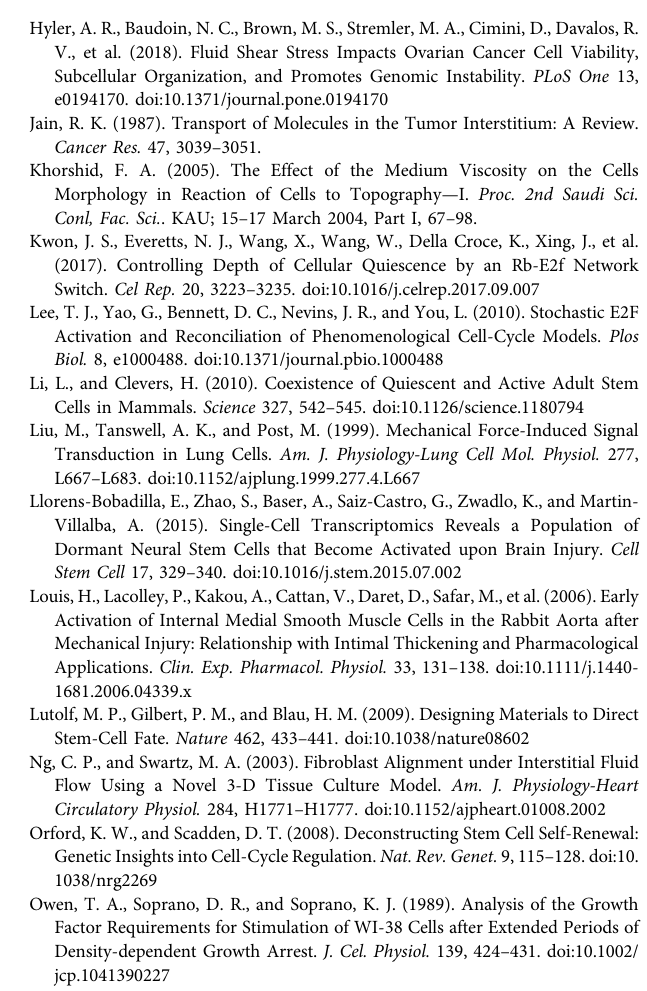
average E2f-On% or EdU+% as indicated from duplicate samples (black and grey histograms). (Right) Statistic bar chart of E2f-On% and EdU+% from the left-panel histograms. Error bars, SEM (n = 2), * p < 0.05, ** p < 0.01, *** p < 0.001. (D) Dot plots of Fig 3A. Y-axis, forward-scatter; x-axis, E2f-GFP. Supplementary Figure S2 | The effect of varying dextran concentrations on quiescence depth in static culture. REF/E23 cells were induced to and maintained in quiescence by culturing them in static serum-starvation medium (in well plate) for 4 days with dextran at the indicated concentrations. Cells were subsequently stimulated with serum at the indicated concentrations for 26 hours, and the E2f-On% were assayed. (A) E2f-GFP histograms with red numbers indicating the average E2f-On% from duplicate samples (black and grey). (B) Statistic bar chart of the E2f-On% in cell populations (from A) as a function of dextran concentration (in serum-starvation) and serum concentration (in serum- stimulation). Bar graphs showing the E2f-On% from the left panels. Error bars, SEM (n = 2), * p < 0.05, ** p < 0.01. Supplementary Figure S3 | Simulation results on the effects of shear stress and extracellular factor replacement on quiescence depth. Simulations of fl uid fl ow rate effects (orange) are the same as in Figure 6B . Simulations of the effects of shear stress(red)andextracellularfactorreplacement(purple)wereperformedinthesame way as the simulations of fl uid fl ow rate effects (orange), except that the FR term in Supplementary Table S1 was multiplied by 0.75 and 0.85, respectively. Blue triangle, the average E2f-On% in response to 2% serum stimulation, in cells under 5 ul/h extracellular fl uid fl ow with the indicated shear stress level during serum starvation (as in Figure 6B , based on Figure 4A and Table 1 ). Each solid curve represents the best fi t of simulation data points to a Hill